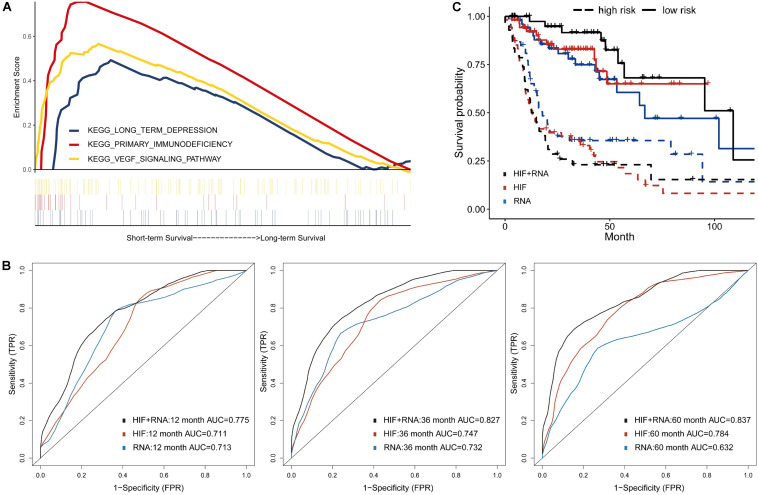
Prognostic model integrating histopathological image features with transcriptomics. (A) Three representative signaling pathways in short-term survival patients of training set by Gene Set Enrichment Analyses (GSEA). (B) The multivariate model of histopathological and transcriptomics features (HIF + RNA) reached higher 1-, 3-, and 5-year AUCs, and (C) more significant survival difference of Kaplan-Meier curves than models of image features alone (HIF) or transcriptomics alone (RNA) in validation set.